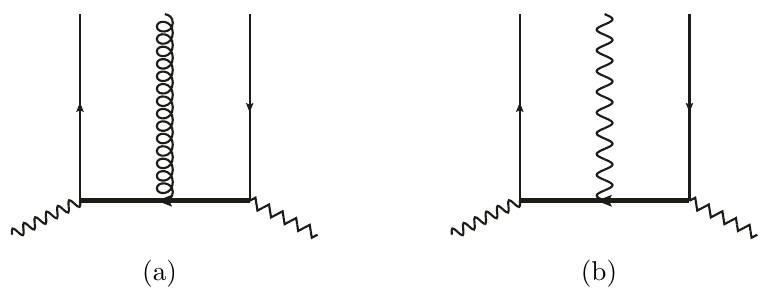
Figure 4 . Diagrammatic representation of the three-particle higher twist corrections to the vacuum-to-photon correlation function (2.5) at tree